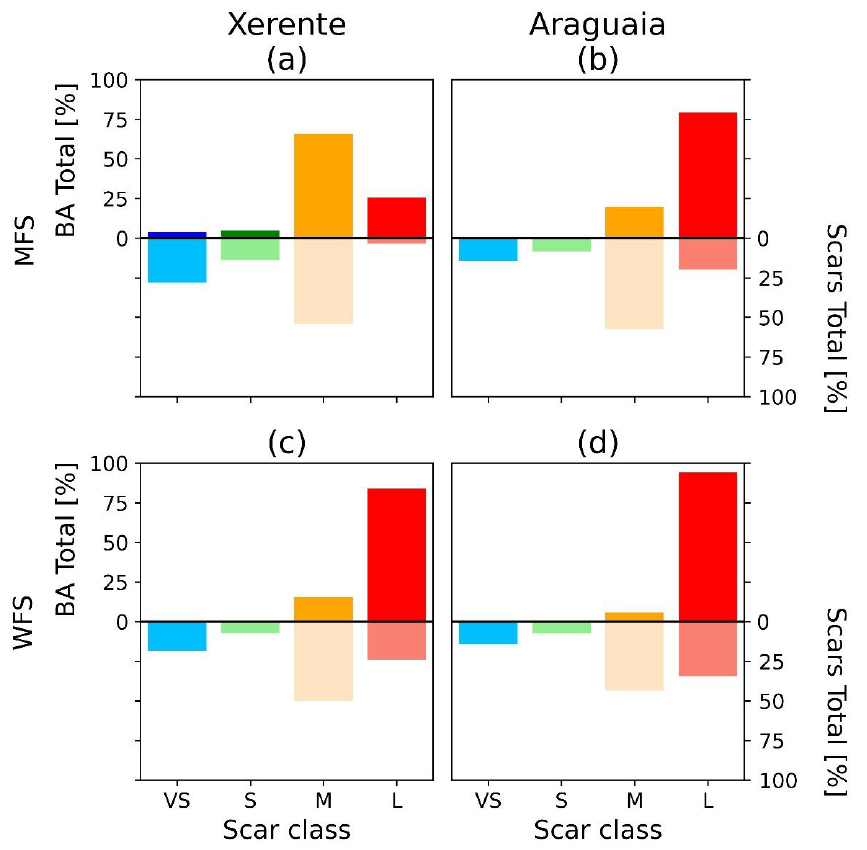
Figure 2. Total burned area (BA, %, full color) and scars (%, smoothed color) per scar size class: very small (VS, blue), small (S, green), medium (M, orange), and large (L, red) in the management fire season (MFS, upper row) and wildfire season (WFS, bottom row) from 2003 to 2018 in Xerente ( a , c ) and Araguaia ( b , d